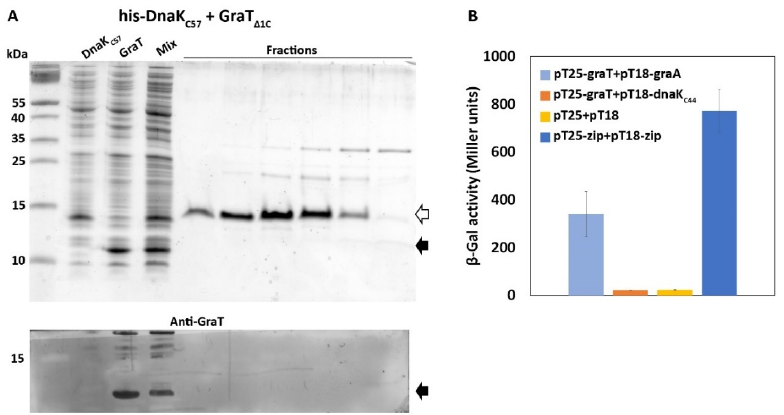
Figure 3. Stable interaction between GraT and C -terminal domain of DnaK could be detected neither in vitro nor in vivo. ( A ) An in vitro pull-down assay with His 6 -DnaK C57 as a bait protein for GraT Δ 1C . The cell lysate (Mix) prepared by mixing two E. coli cultures overexpressing either His 6 -DnaK C57 or GraT Δ 1C was loaded onto Ni 2+ affinity column and column elution fractions were analyzed on Coomassie-stained SDS-PAGE gel. Lower panel represents the Western blot analysis of an identical gel with anti-GraT antibodies. His 6 -DnaK C57 and GraT Δ 1C are indicated by the empty and solid arrows, respectively. ( B ) An in vivo bacterial two-hybrid assay for analyzing the functional complementation between T25 and T18 fragments of Bordetella pertussis CyaA. β -galactosidase activities were measured in E. coli BTH101( Δ cyaA ) co-transformed with two plasmids that encode proteins of interest (GraT, GraA, and 44 amino acid-long C -terminal end of DnaK) fused with T25 and T18. Plasmid pairs pT25+pT18 and pT25-zip+pT18-zip served as negative and positive controls, respectively. Bacteria were grown overnight at 37 °C on LB agar plates supplemented with 1 mM IPTG. The results are the average of four independent replicates and error bars represent the standard deviation.